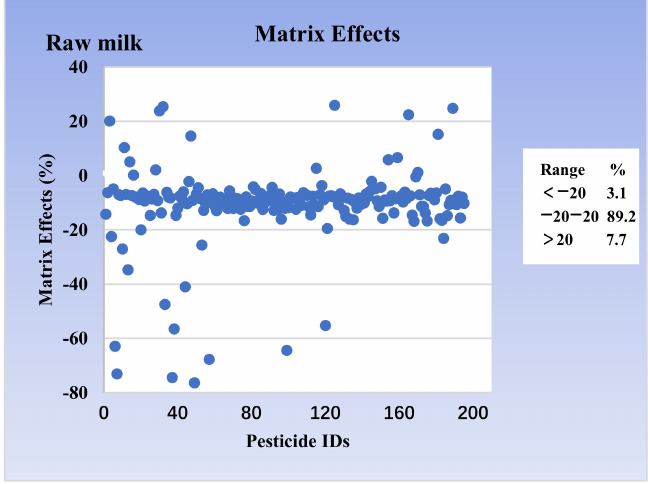
Figure 4. Matrix effect distribution of pesticides in raw milk analysis